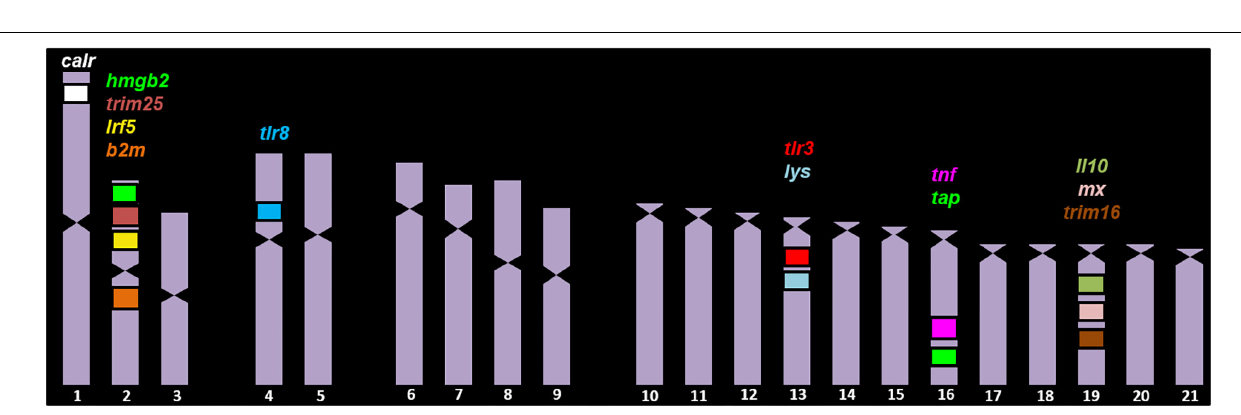
FIGURE 2 | BAC clones analyzed in the chromosomes of S. senegalensis. On chromosome 1 the BAC clone calr was localized; on chromosome 2 there were four BAC clones, with the genes b2ml , b2m , irak3 , trim25, hmgb2, and irf5 . On chromosomes 4 and 12 the BAC clone 30J4 was localized, with the genes tlr8, tlr7, and nlrc3 . The BAC clones 4N21 and 29D4, with the lysg and tlr3 candidate genes, respectively, were found on chromosome 13. On chromosome 16, the BAC clones 53D20 and 71N11 were localized, with the genes tap , hla-drb1 , tnf α and pycard . Lastly on chromosome 19 the BAC clones 42P4, 12K6 and 31C1 were localized, with the genes il10, il19, mx, trim16, ikbke